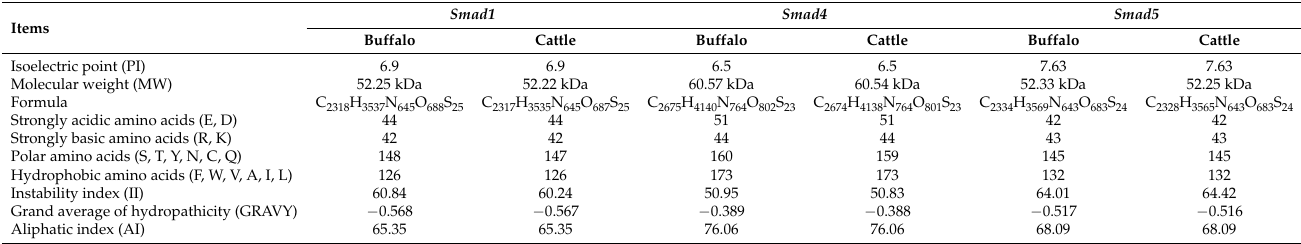
Table 2. Basic characteristics of Smad1/4/5 for buffalo and